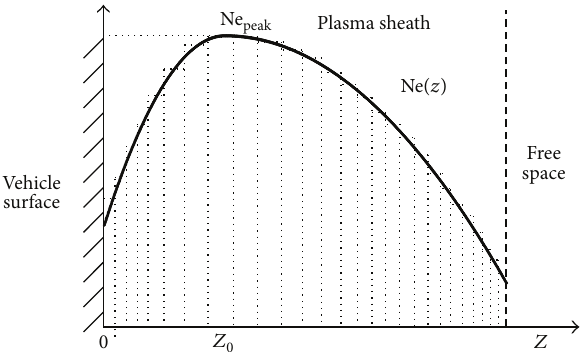
Figure 1: Variation profile of an electron density radially outward from vehicle